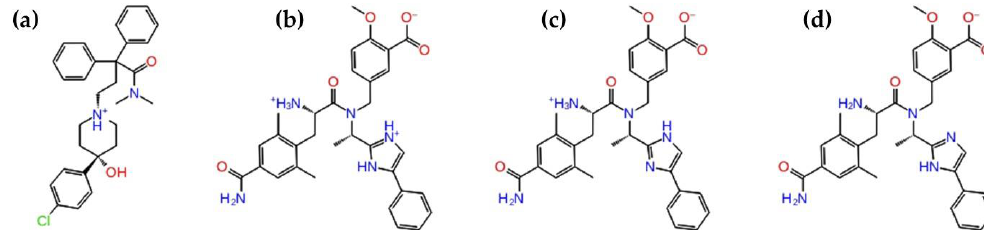
Figure 1. 2D structures of ( a ) loperamide and ( b – d ) eluxadoline. For eluxadoline, the three most populated protonation state simulated at a range of pH (6–8) corresponding to the gastrointestinal tract were reported: ( b ) eluxadoline at pH 6 (E1), ( c ) eluxadoline at pH 7 (E2) and ( d ) eluxadoline at pH 8 (E3).